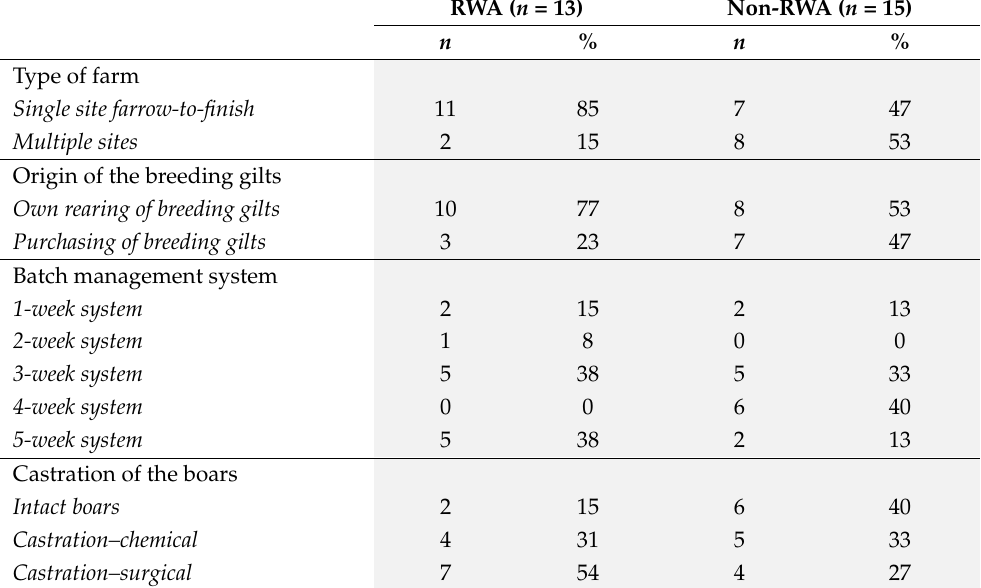
Table 3. Farm characteristics of the Raised Without Antibiotics (RWA) ( n = 13) and the non-RWA pig farms ( n =